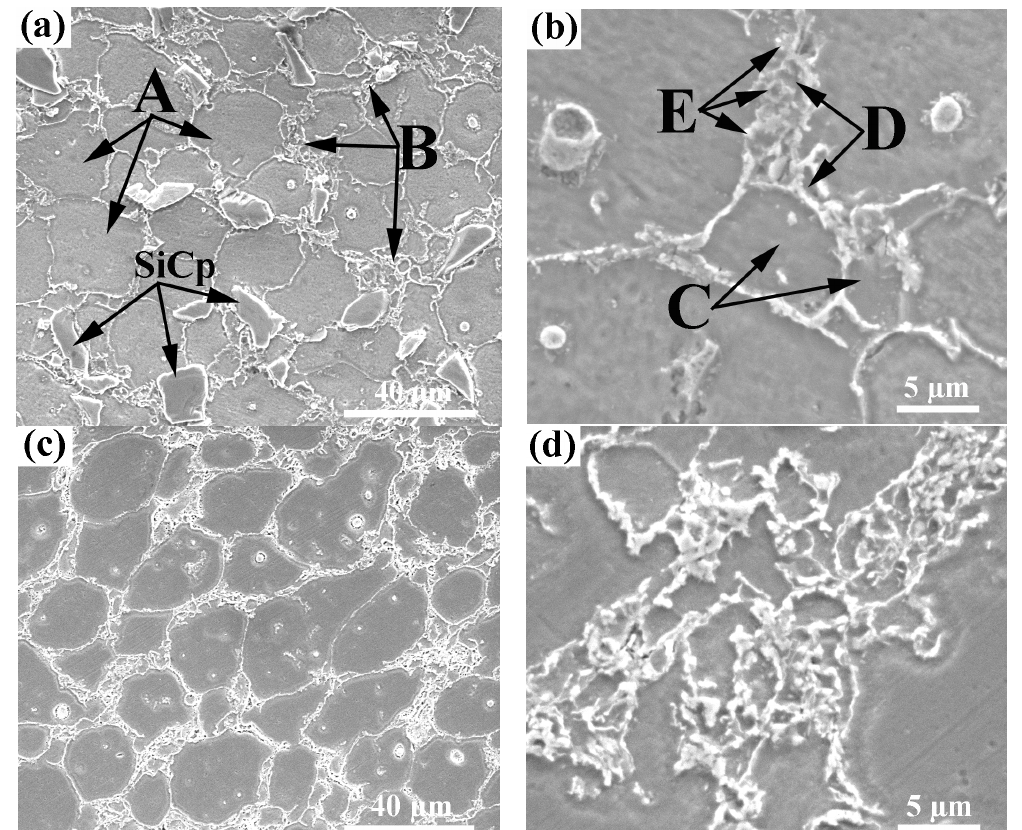
Figure 4. SEM micrographs of ( a , b ) 2024Al/SiC p composite and ( c , d ) 2024 alloy.